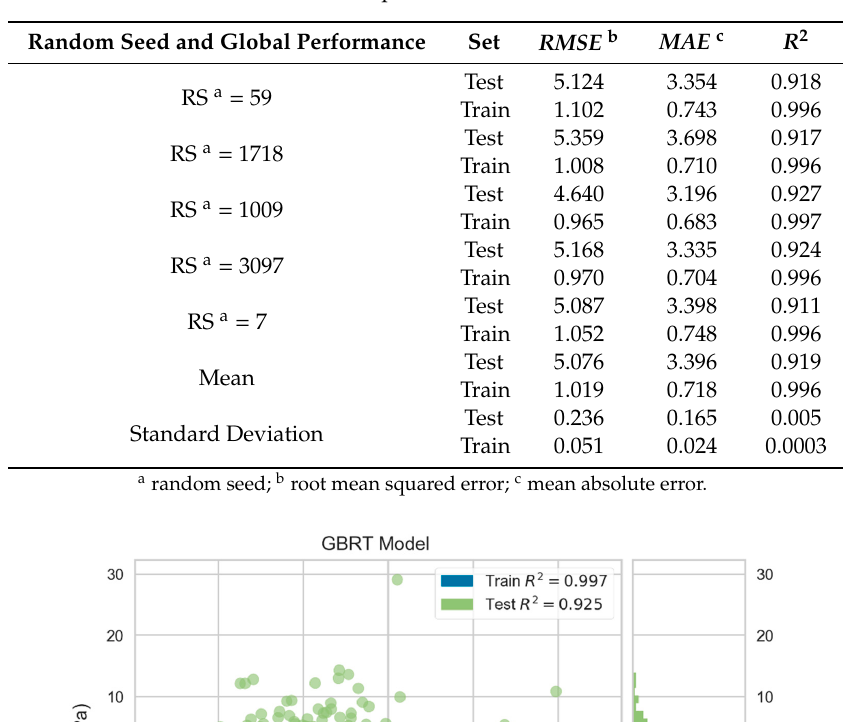
Table 13. Measured performance of GBRT model.